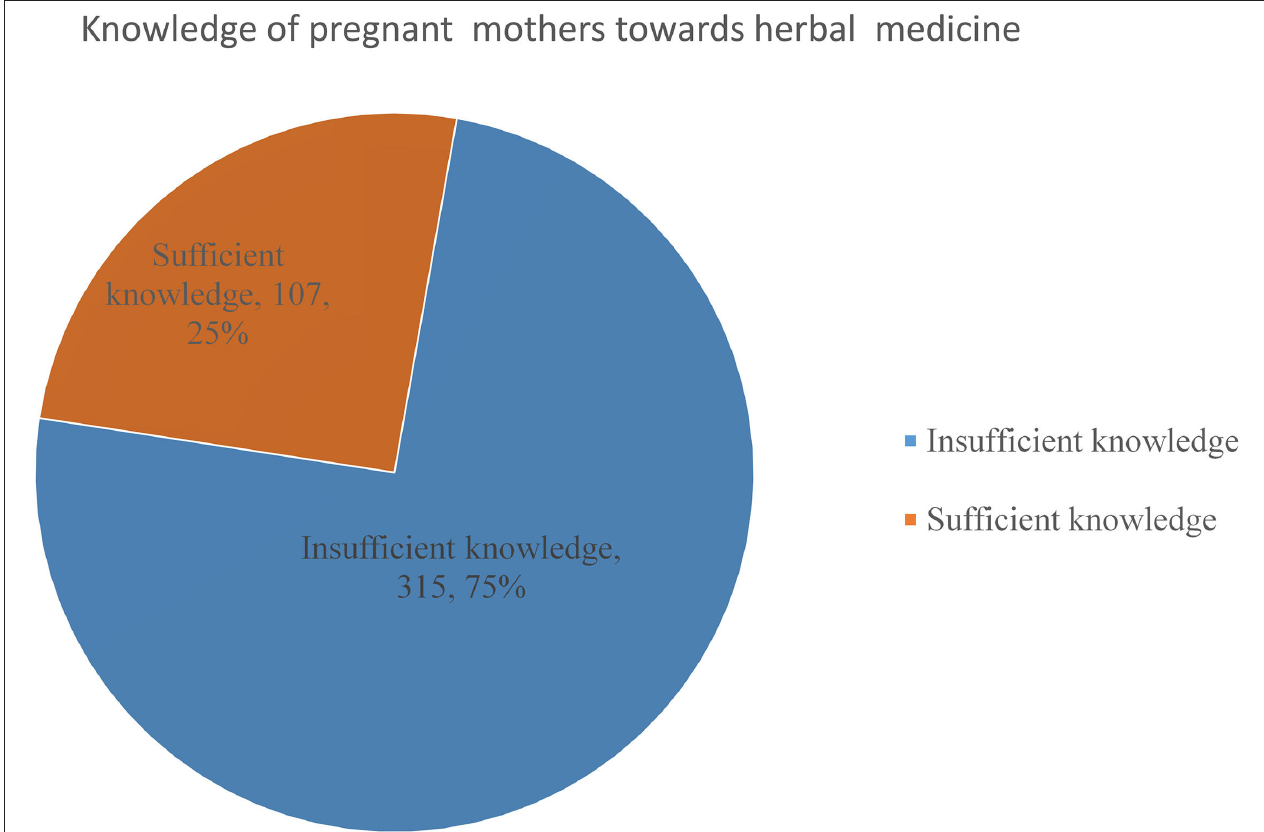
FIGURE 2 | Knowledge of pregnant mothers toward herbal medicine among mothers who visited governmental health institutions for antenatal care in Debre Behan town,